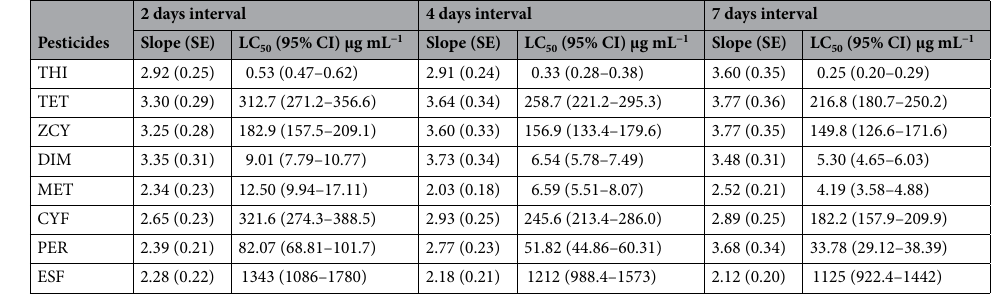
Table 1. Acute toxicity of eight pesticides to honey bee workers at different duration, expressed as median lethal concentration (LC Zeta -cypermethrin, DIM Dimethoate, MET Methomyl, CYF Cyfluthrin, PER Permethrin, ESF